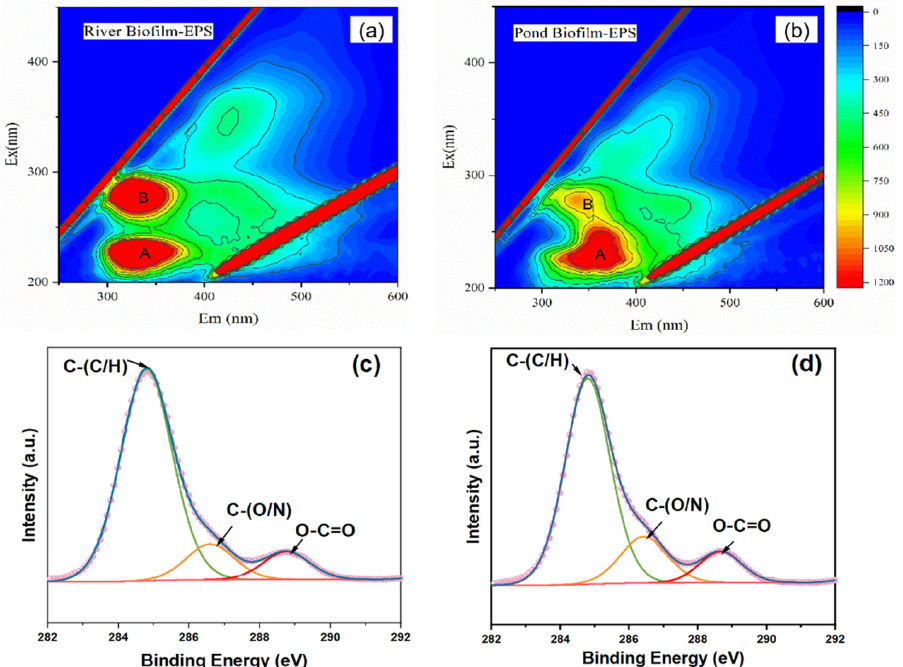
Figure 5. Fluorescence excitation–emission matrices of ( a ) River Biofilm EPS and ( b ) Pond Biofilm EPS. Additionally, XPS spectra for carbon (C1s) of ( c ) River Biofilm EPS and ( d ) Pond Biofilm EPS.